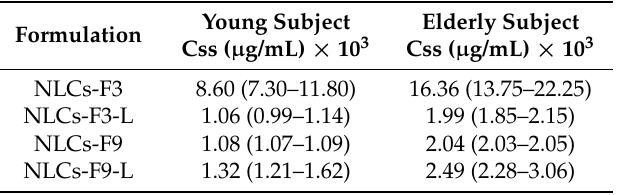
Table 6 exhibits the results obtained from the predicted steady-state plasma concentration of PF after the application of selected NLCs on 100 cm 2 of skin. All the Css values obtained for the selected formulations were below the therapeutic plasma concentration. Table 6. Predicted steady-state plasma concentration Css of the PF after the application of each formulation on 100 cm 2 of skin. Therapeutic plasma concentration: 4.89 ± 1.29 µ g/mL and 10.19 ± 2.43 µ g/mL for young and elderly subjects, respectively. Data are represented as median